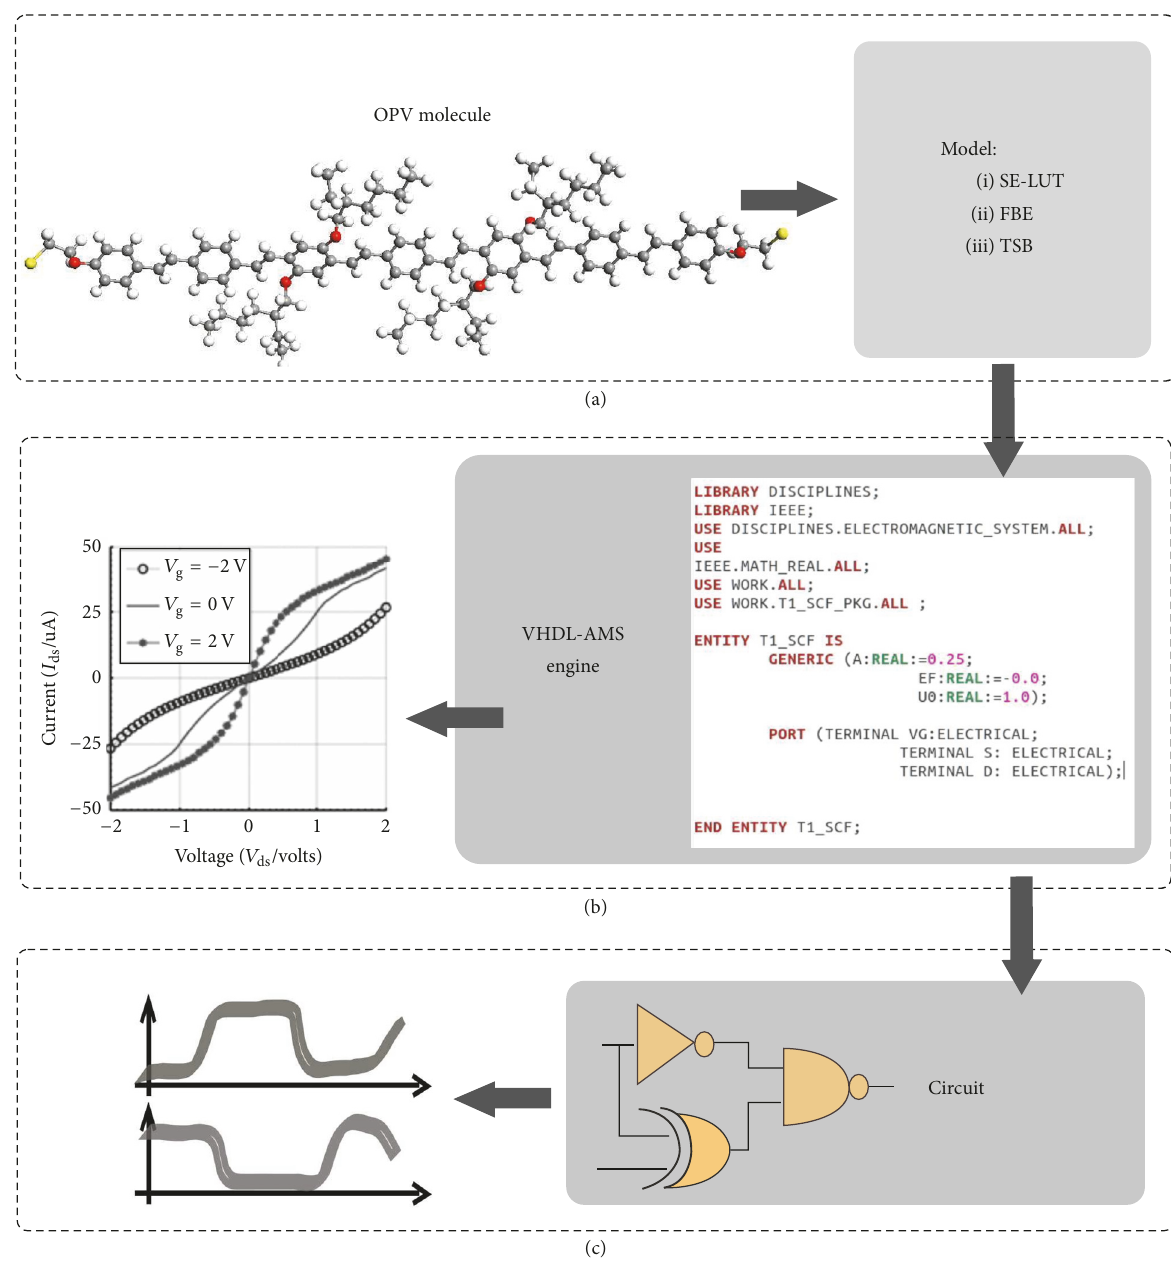
Figure 1: Flow of methodology. (a) The OPV molecule coupled to the electrodes through oxygen linkers is simulated in ATK for 𝐼 - 𝑉 characteristics. The conduction through the molecule is calculated at different bias conditions by the three models: semiempirical look-up table SE-LUT, transmission spectrum based (TSB) model, and FET-based equivalent model FBE. (b) VHDL-AMS based engine elaborates the results obtained by the three models, generates the corresponding 𝐼 - 𝑉 characteristics, and provides the description of MOL-FET in VHDL- AMS. (c) Logic circuits based on MOL-FET can be hierarchically implemented. Correct circuit behavior and performance can be evaluated by the simulation of the